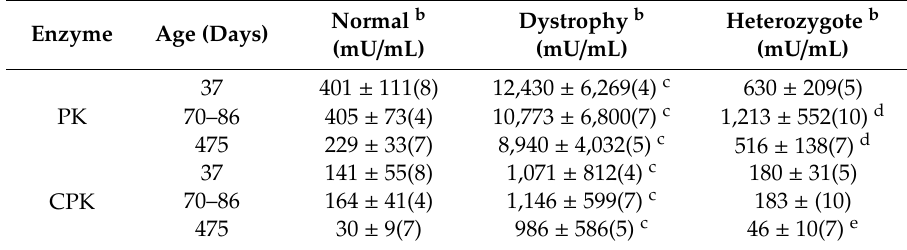
Table 2. Blood serum pyruvate kinase (PK) and creatine phosphokinase (CPK) activities in normal, dystrophic and heterozygous carrier chicks a .